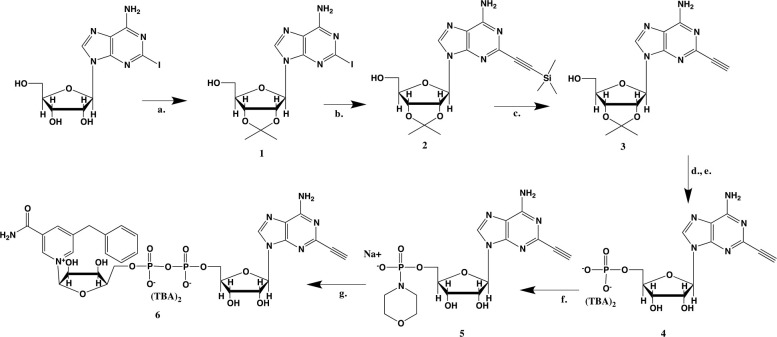
Synthesis of 5-bn-2-ethynyl NAD+.(a) p-TsOH, acetone, sodium carbonate; (b) (PPh3) PdCl2, CuI, TEA, TMS-acetylene; (c) 7N NH3/MeOH; (d) POCl3,TEA, THF, 0 °C; (e) TFA, 1:1 MeOH H2O; (f) PPh3, Morpholine, 2,2-DPS, 0.2 M NaI in ACN; (g) 5-Bn-NMN, MgSO4, 0.2 M MnCl2 in dry formamide.